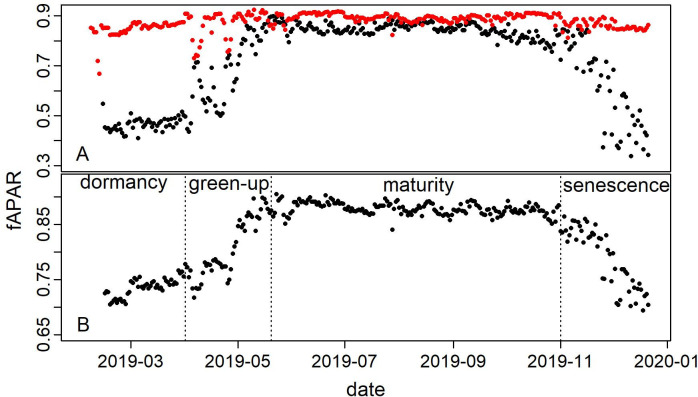
Daily fraction of absorbed PAR (fAPAR) in 2019.(A) daily grass (red) and tree (black) fAPAR. (B) daily ecosystem average fAPAR, assuming 70% and 30% cover of grass and trees, respectively. The phenophases (dormancy, green-up, maturity and senescence) refer to development stages of the deciduous tree species of the study area.